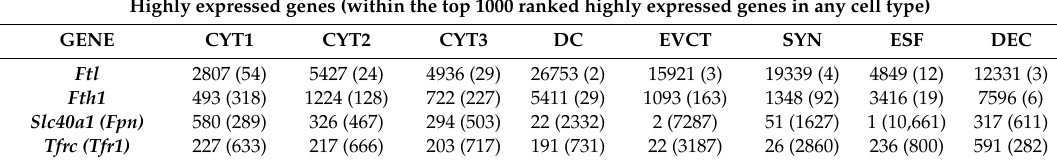
Table 1. Expression of iron homeostatic and ferroptotic genes in di ff erent cell types at the maternal-fetal interface at term